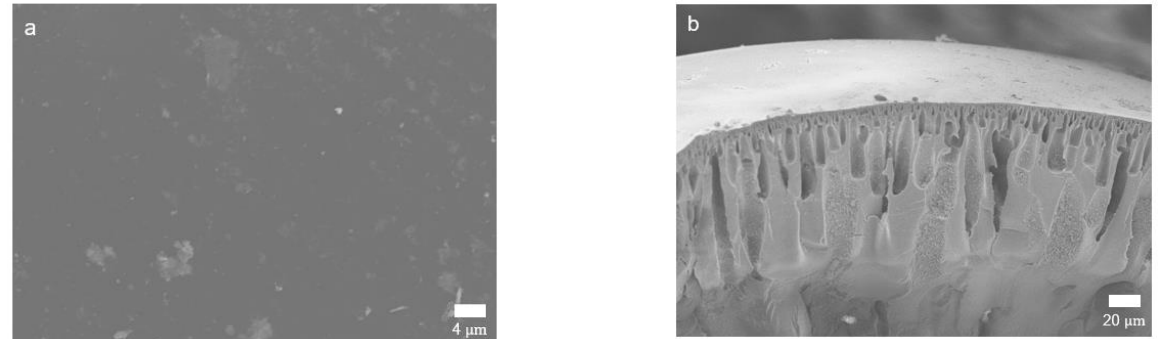
Figure 9. ( a ) Surface and ( b ) cross-sectional SEM images of the crosslinked PBI membrane after the filtration test at pH 13.